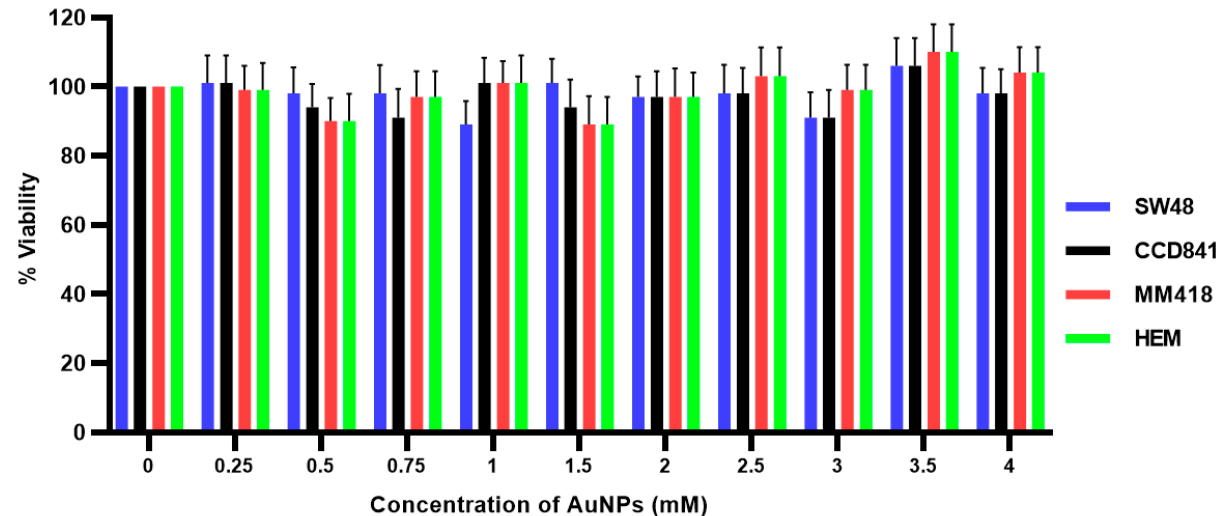
Figure 2. Effect of AuNPs on the viability of human colon adenocarcinoma (SW48) and melanoma (MM418-C1) cell lines compared to their non-cancerous counterparts (CCD841 and HEM cells). The cells were treated with 0–4 mM AuNPs for 48 h and cell viability (viability%) was determined using the MTS assay. No significant differences in cell viability were seen in all cell types at different concentration of AuNPs ( p > 0.05). Results expressed are the mean ± SEM of 3 replicates.